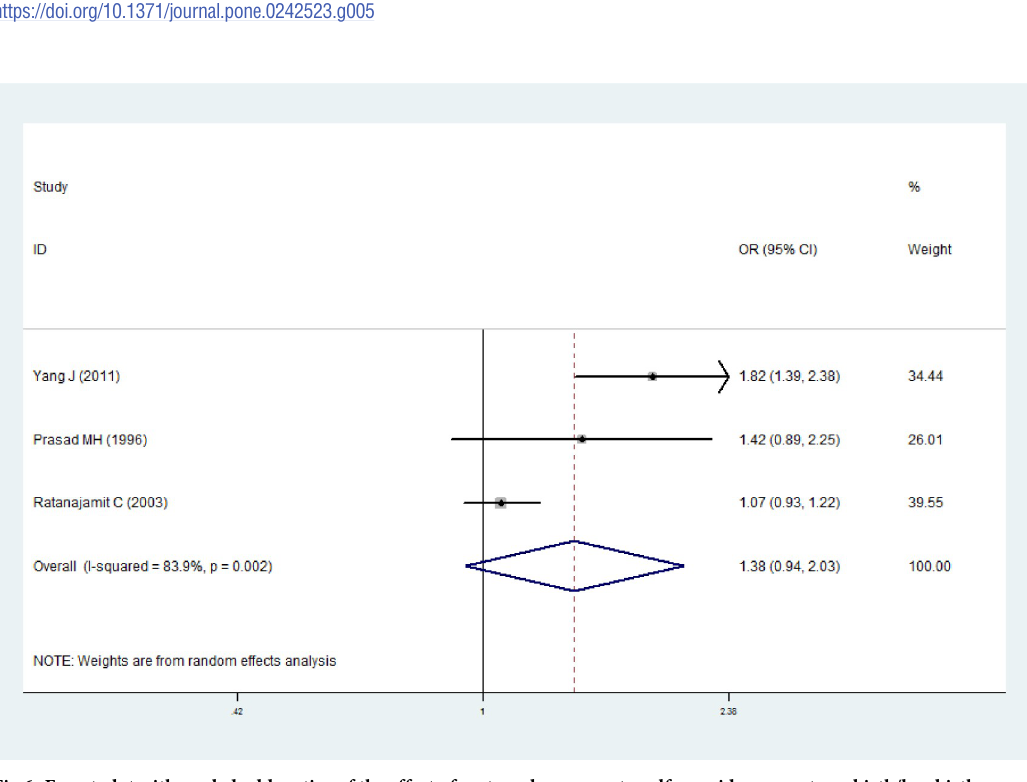
PLOS ONE | https://doi.org/10.1371/journal.pone.0242523 December2,